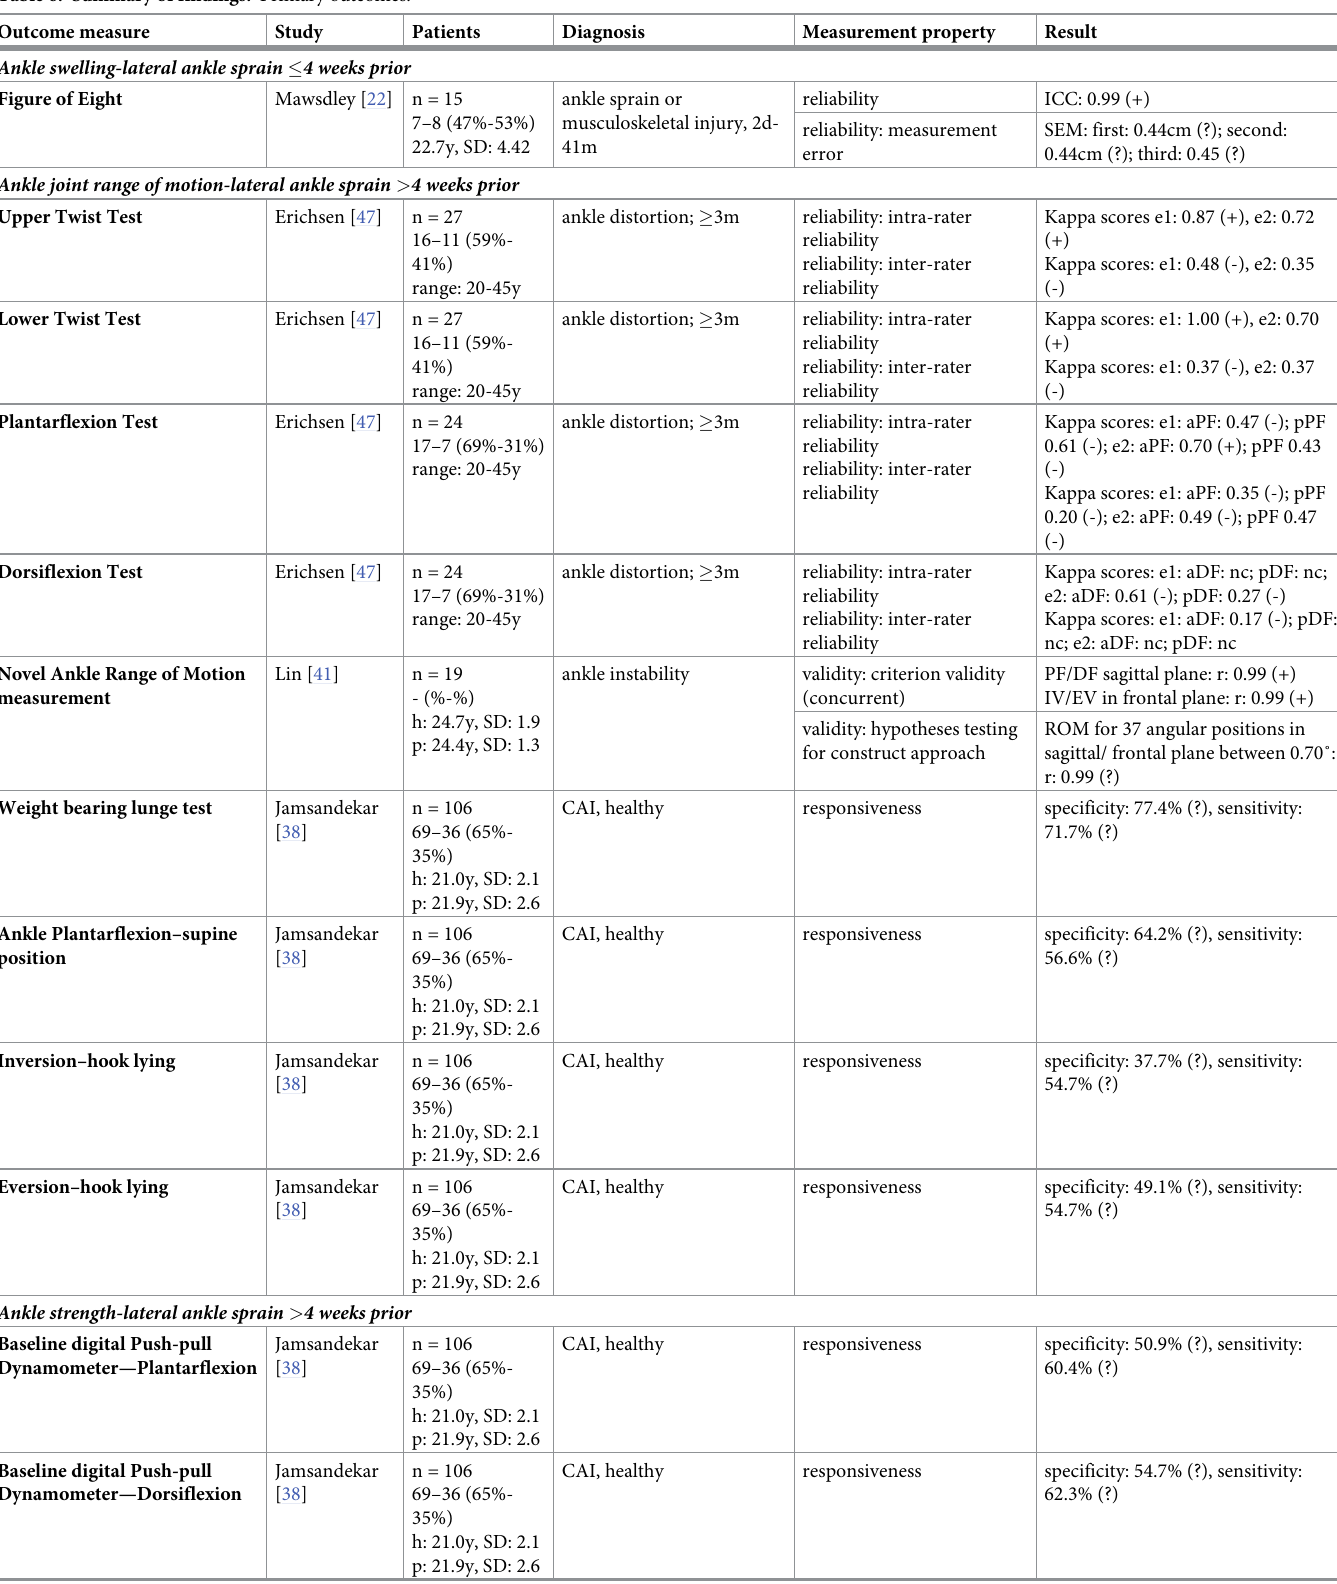
Table 6. Summary of findings. Primary